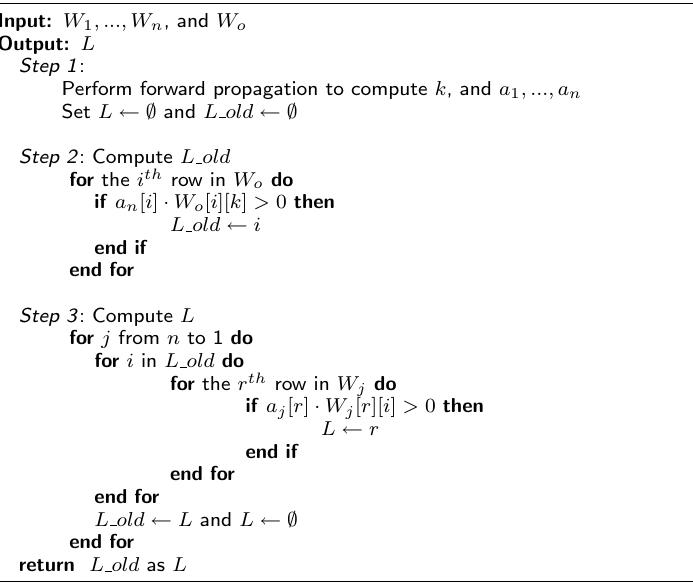
Algorithm 1 The Backtracking